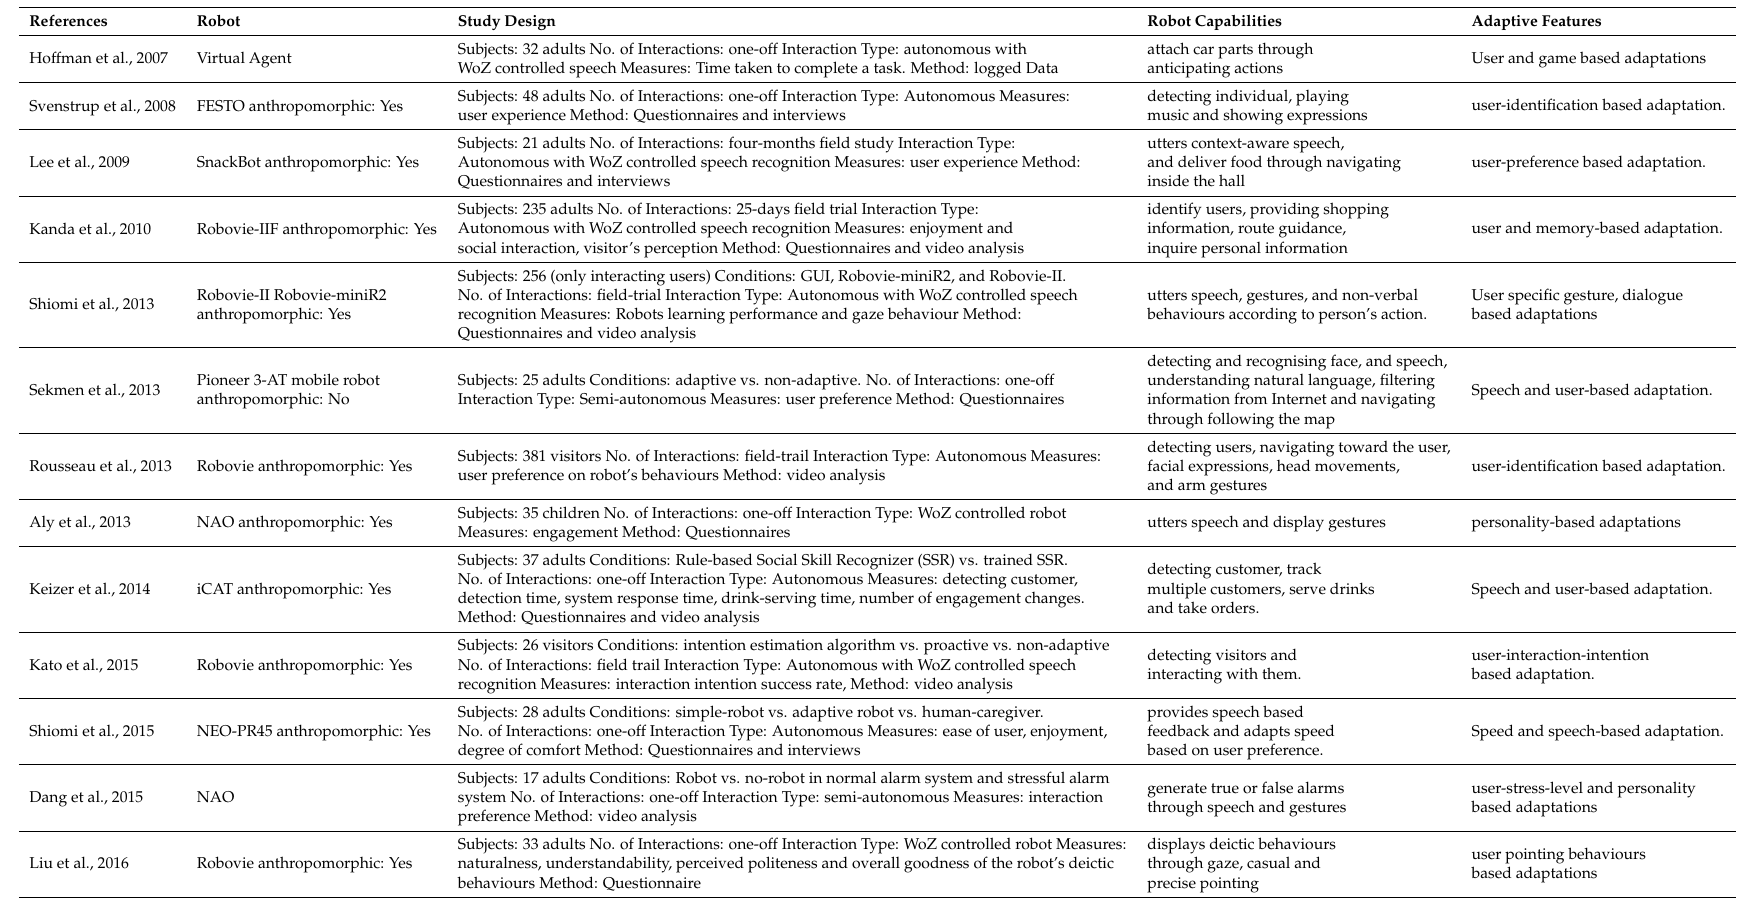
Table 3. Summary of Adaptive Interaction studies in work environment and public spaces. Study Design Questionnaires and interviews